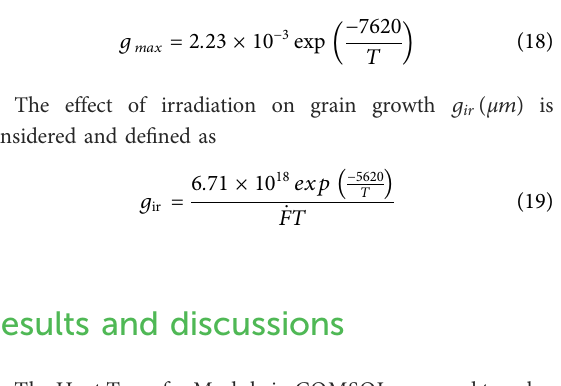
FIGURE 8 Fuel thermal conductivity against temperature for burnup of 1 at%, 3 at%, and 5 at% (deviation from the stoichiometry of oxygen = 0.05).